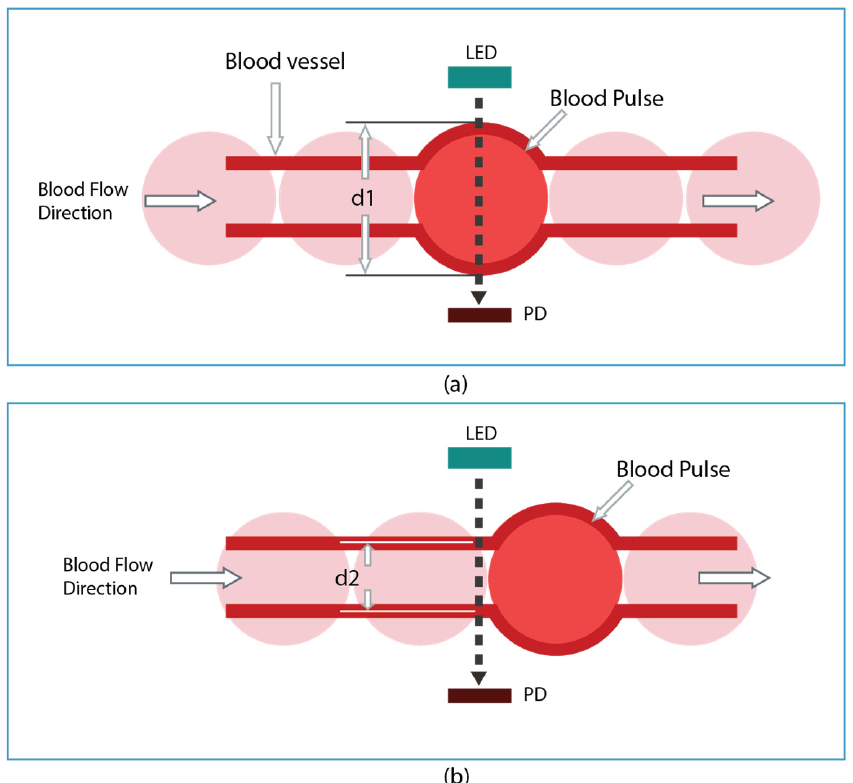
Figure 1. Blood vessel model: ( a ) light intensity in the systolic phase, and ( b ) light intensity in the diastolic phase.